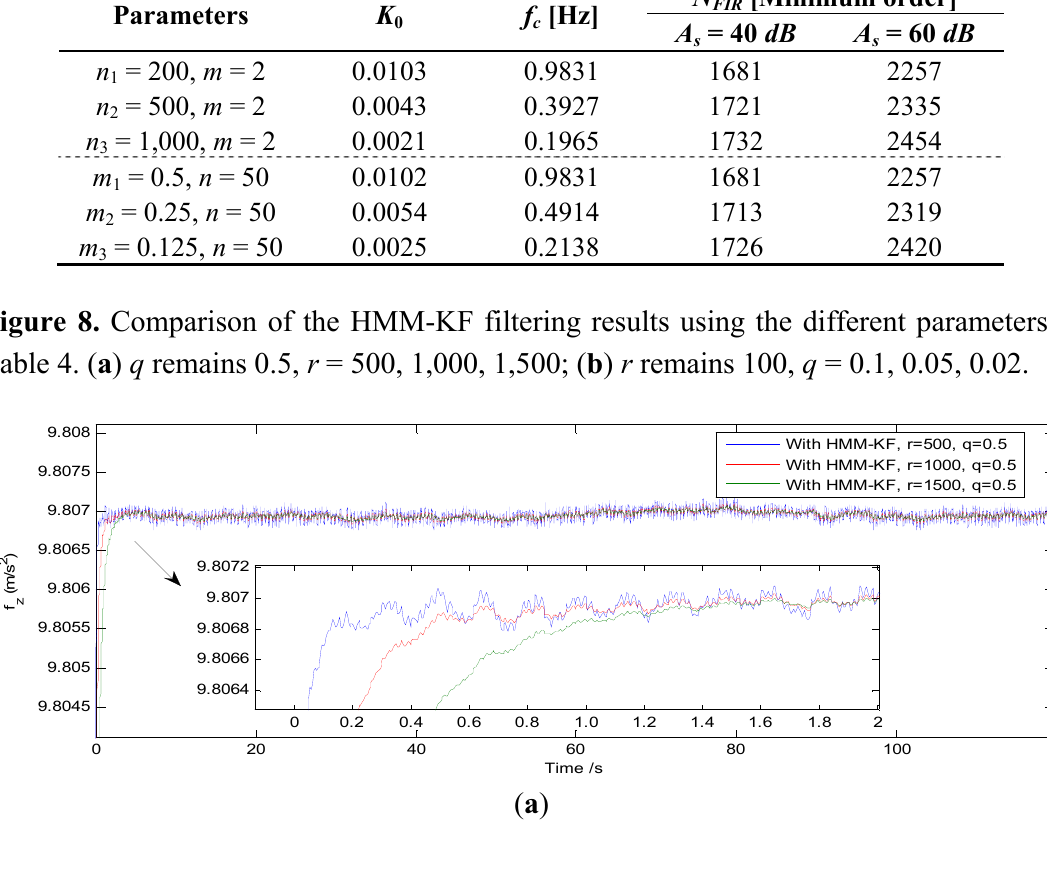
, f and N with different m and n . 0 c FIR